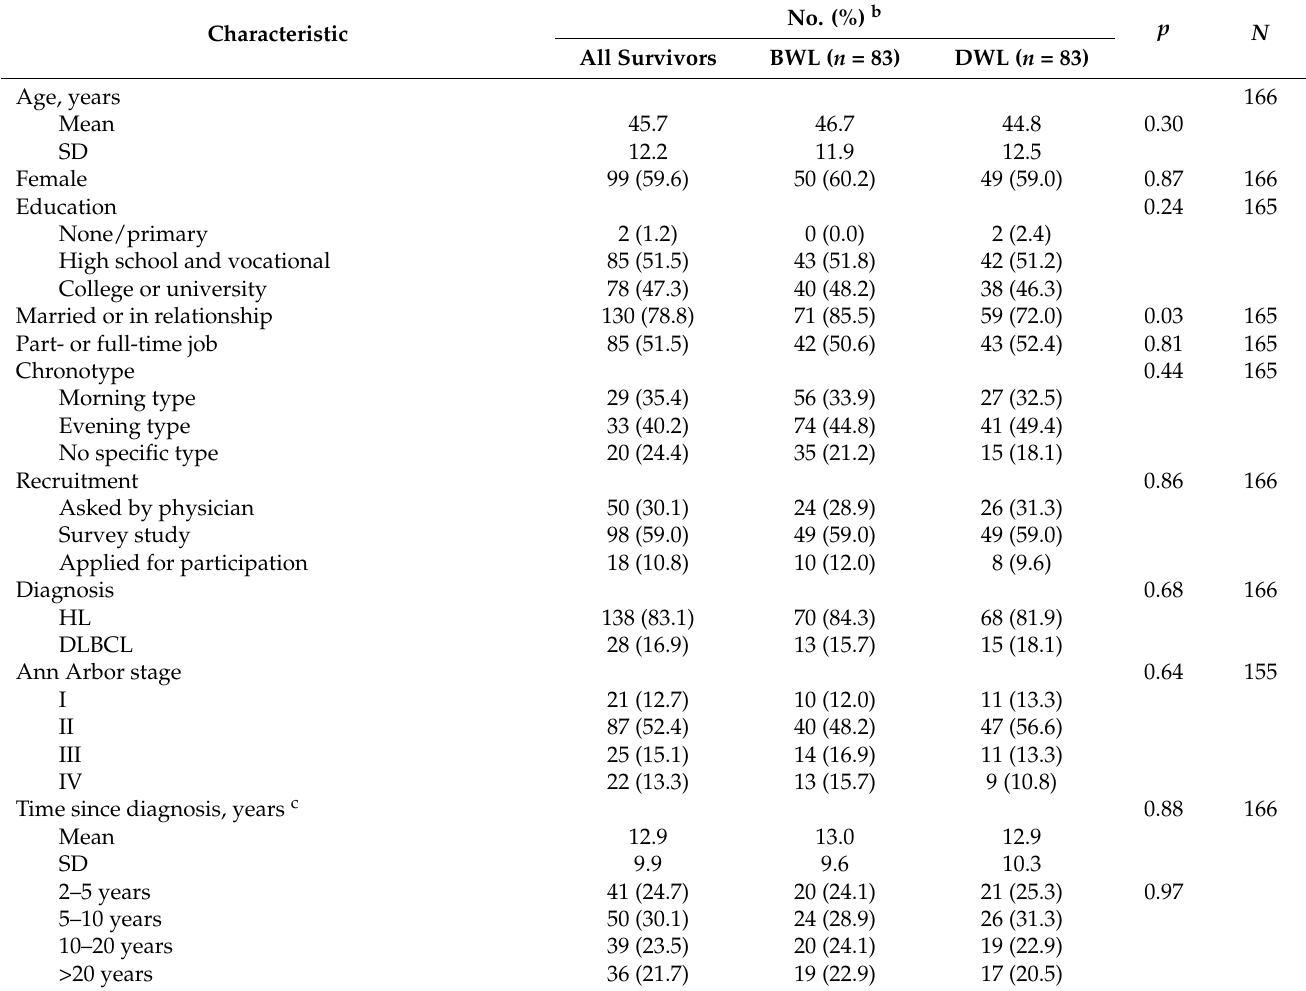
Table 2. Baseline sociodemographic, clinical, and fatigue characteristics ( N = 166) a